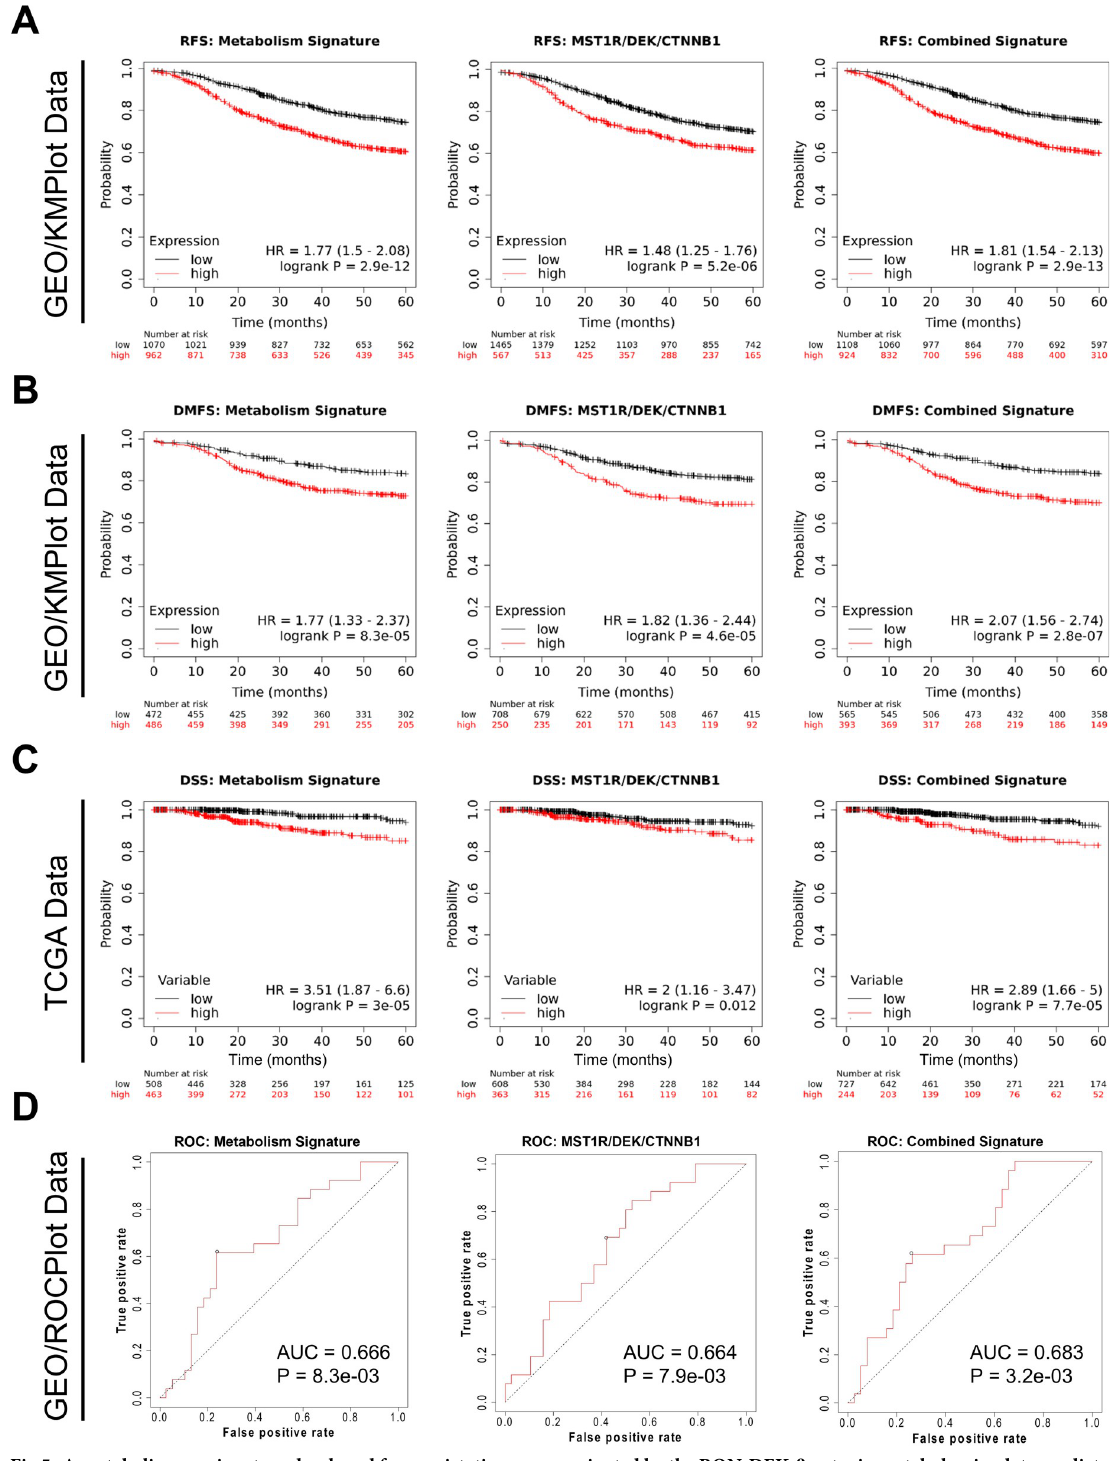
Fig 5. A metabolic gene signature developed from epistatic genes nominated by the RON-DEK- β -catenin metabolomics data predicts breast cancer patient outcomes. Gene Expression Omnibus-derived KMPlot breast cancer datasets [22] were used to query ( A ) Relapse- free survival (RFS) of breast cancer patients stratified by expression of the Metabolism signature (left; see S2–S6 Figs , Table 1 ), RON-DEK- β -catenin (MST1R/DEK/CTNNB1) signature (middle), and both combined (Combined Signature, right) and ( B ) Distant metastasis-free survival (DMFS) of breast cancer patients stratified by expression of the Metabolism signature (left), RON-DEK- β -catenin (MST1R/DEK/